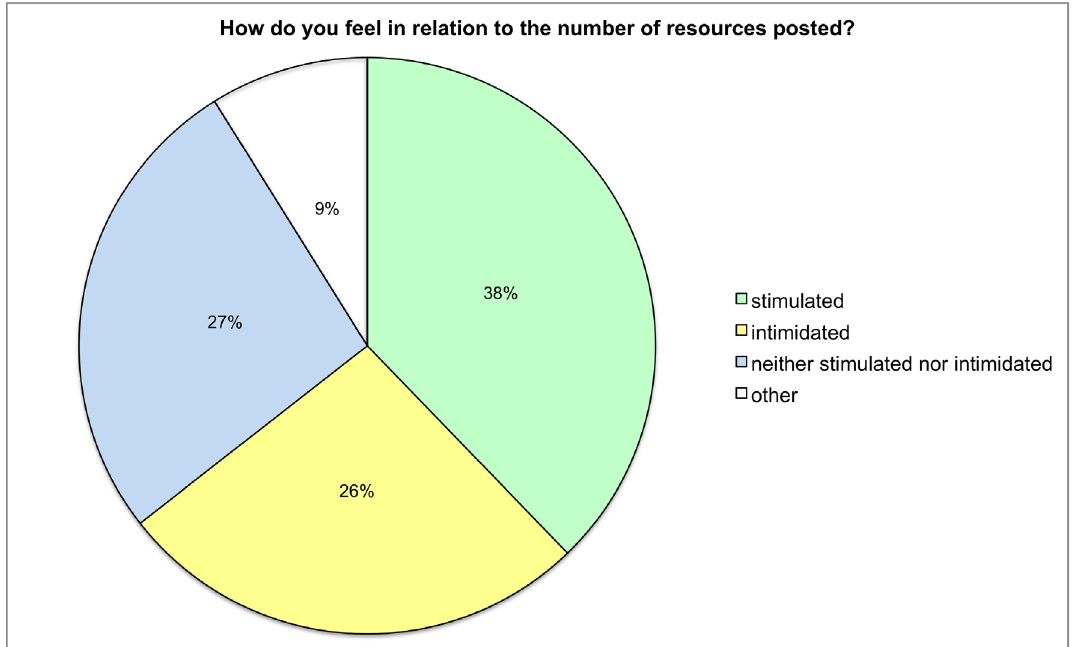
Figure 8 . Student feelings about the number of extra resources